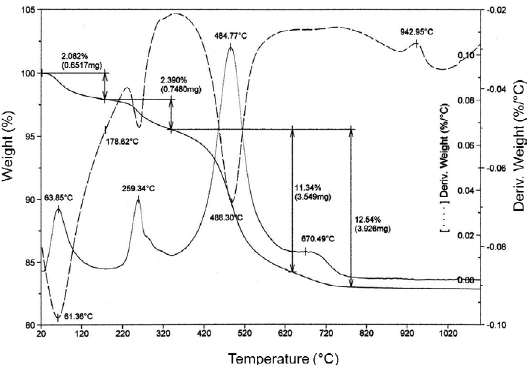
Figure 5. Thermal analysis curves (DTA/TG/DTG) of the clay fraction.